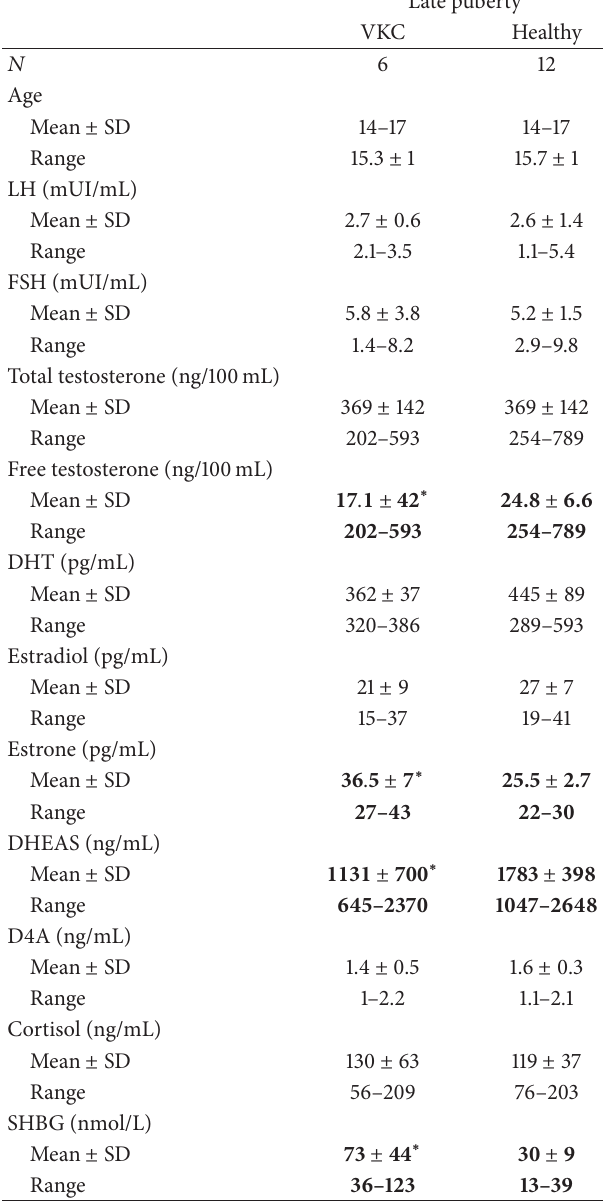
Table 3: Sex hormones serum levels in patients with VKC in remission phase compared to healthy